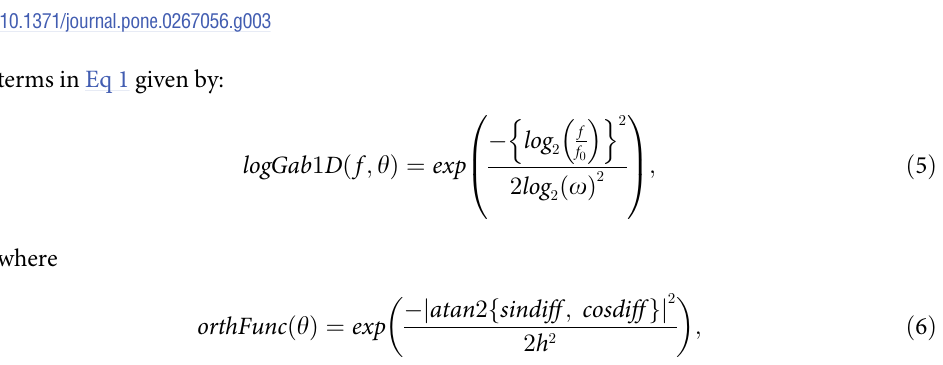
Fig 3. Example log-Gabor filters of different orientation bandwidths for (a) polar-separable and (b) Cartesian-separable filters (see text for details). In each panel, the upper row shows the Fourier amplitude spectra, and the lower row the cosine-phase spatial transform (i.e. the filter kernel). All filters have a spatial frequency bandwidth of 1.43 octaves, and orientation bandwidths ( h in Eq 4) of (from left to right) ± 11.25˚, ± 22.5˚ and ± 45˚. Note how the filter kernels of these narrowband polar filters (lower row, a) splay outwards, whereas the equivalent Cartesian filter kernels do not (lower row,